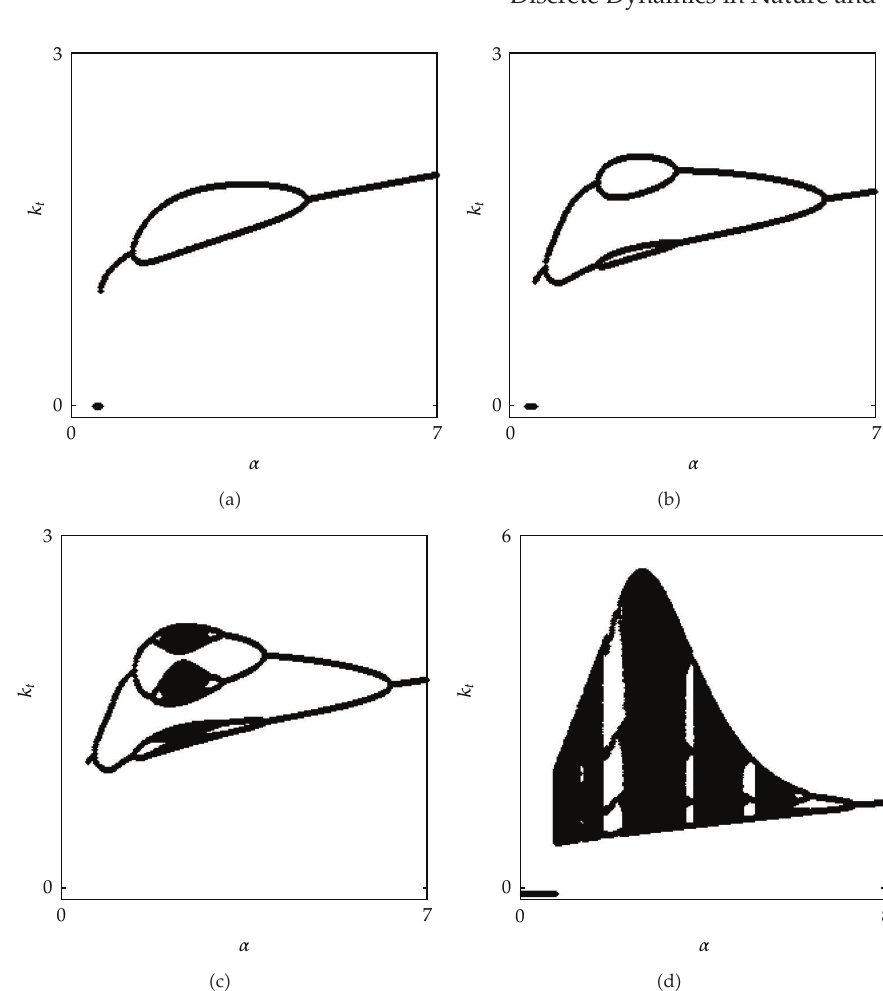
Figure 11: Bifurcation diagrams w.r.t. α for di ff erent values of p and for the following parameter values: δ (cid:7) 0 . 2, s r (cid:7) 0 . 8, s w (cid:7) 0 . 1, β (cid:7) 0 . 9, n (cid:7) 0 . 5 and the initial condition k 0 (cid:7) k m ; (cid:3) a (cid:6) p (cid:7) 6; (cid:3) b (cid:6) p (cid:7) 7 . 5, (cid:3) c (cid:6) p (cid:7) 8, (cid:3) d (cid:6) p (cid:7)